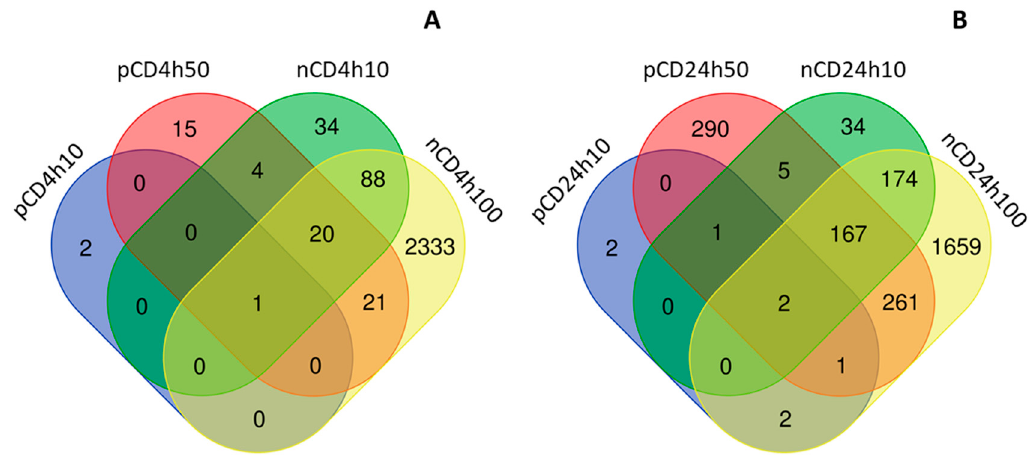
Figure 8. The distribution of common and unique mRNAs differentially expressed after CD NP exposure; a comparison between CDs exposure for 4 h ( A ) versus 24 h ( B ).